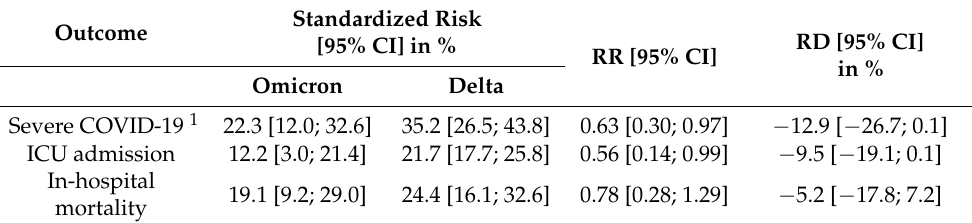
Table 2. Standardized risk by variant (in %), relative risk (RR), and risk difference (RD, in %) estimates, and 95% confidence interval (CI) for severity outcomes within a multi-center cohort study to assess the impact of SARS-CoV-2 variants on COVID-19 disease severity among hospitalized patients in